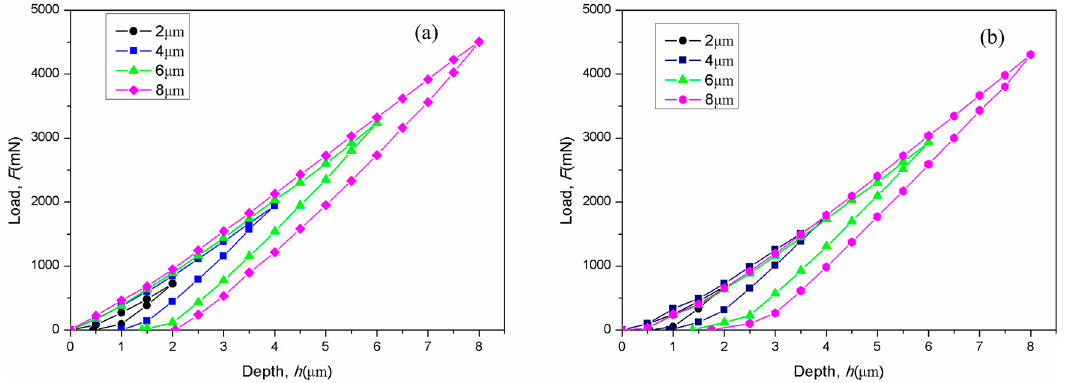
Figure 6. Loading-unloading curves of ( a ) A-plane ( b ) C-plane sapphire.